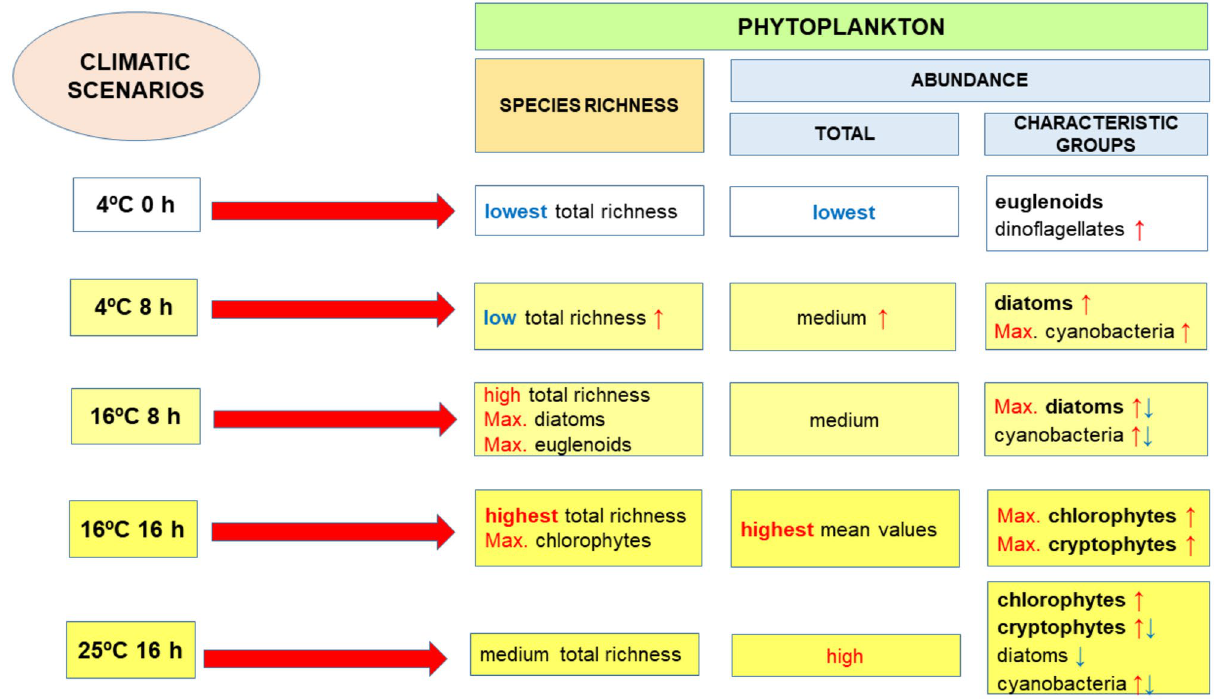
Figure 7. Summary of the effects of different climate scenarios on phytoplankton communities (species richness, Shannon–Weaver diversity index values and abundance) over time. Legend: ↑ —increase, ↓ —decrease, bold: dominant groups. The graph was created using MS PowerPoint